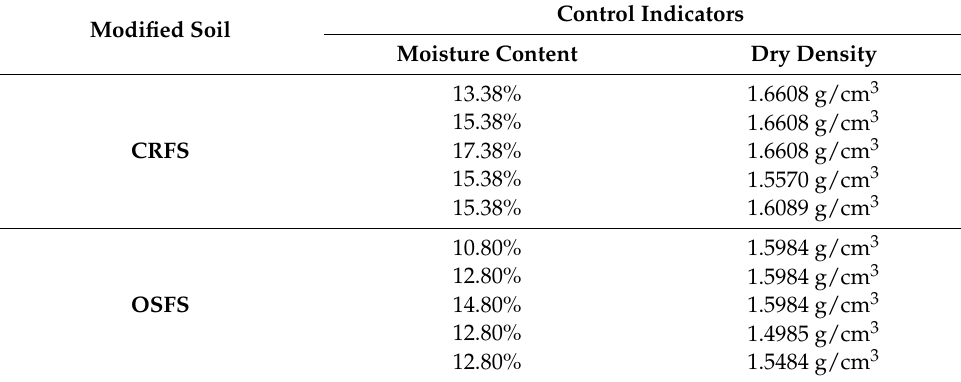
Table 3. Preparation scheme of modified soil